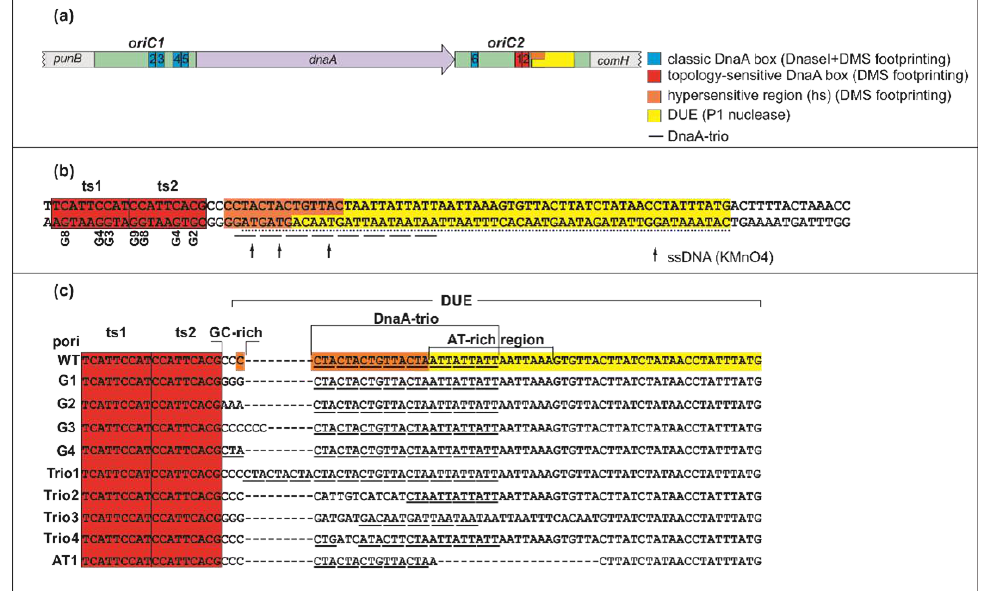
Figure 1. H. pylori bipartite origin. ( a ) Schematic presentation of H. pylori bipartite oriC . Important origin modules are marked. See also the Introduction and [37,40] for details. ( b ) The sequence of the ts boxes-DUE region. Potassium permanganate (KMnO 4 ) sensitive sites are marked (see also Figure S1). The guanine residues (G) in ts boxes modified by dimethyl sulfate (DMS) in footprinting analyses are given below the sequence (5 ′ - 3′ numbering of the bottom strand residues). ( c ) Schematic representation of the modifications introduced into the pori plasmids. The DNA unwinding element (DUE) and hs regions (highlighted yellow and orange, respectively) are only marked for poriWT plasmids; they were determined experimentally in this work for other mutated plasmids.